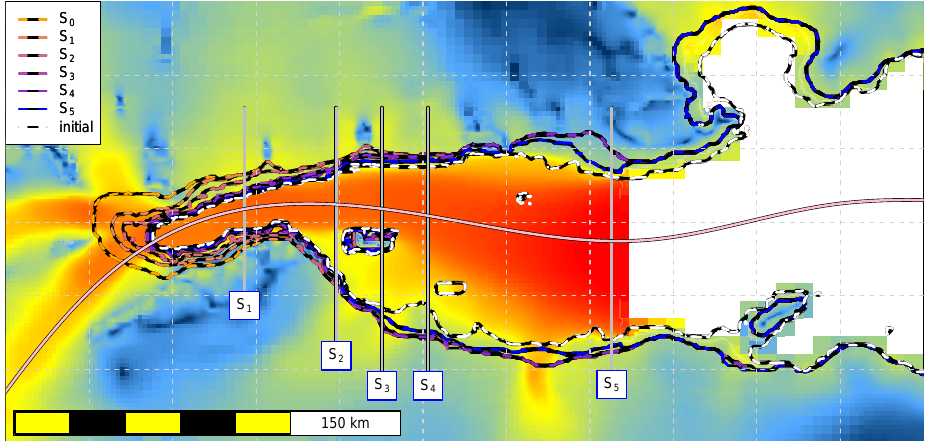
150 km Figure 9. Grounding line migration due to extreme forcing. Initial and year 2200 grounding lines are shown for all of the partial ice-shelf removal experiments. Despite the removal of the northern 25000km 2 of ice shelf, experiment S 5 (whose initial ice flow speed is also shown) exhibits little retreat in the southern reaches. Likewise S 4 and S 3 , even though a further 10000–12500km 2 region of the shelf disappears. S 2 removes another 2500km 2 , from the region east and west of Clemence Massif, and the grounding line retreats 25km. S 1 and S 0 (which remove the entire ice shelf each year) show progressively greater